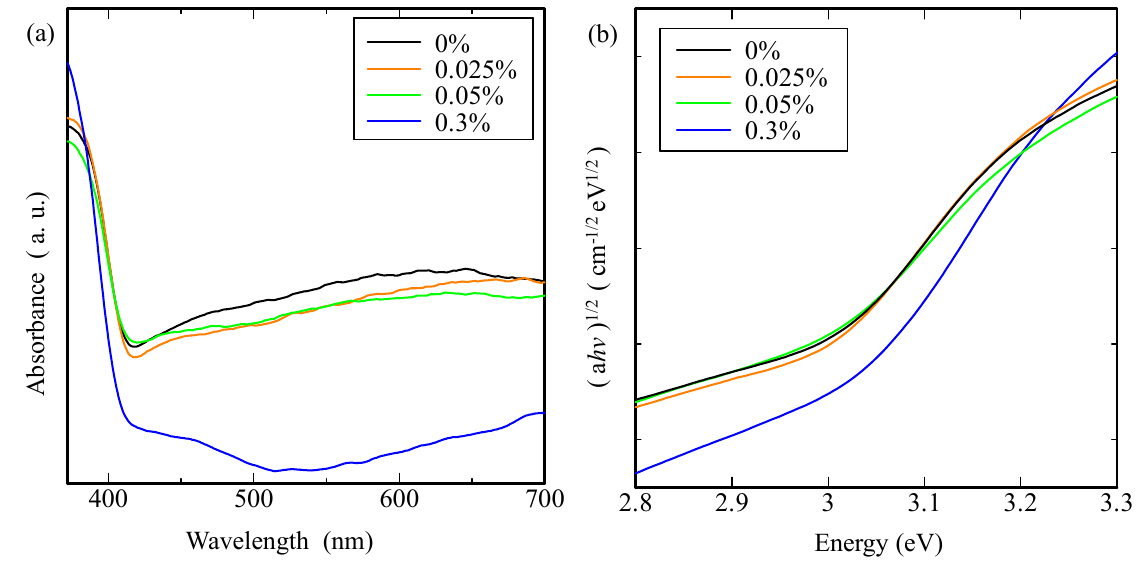
Figure 8. ( a ) UV-Vis absorption spectra; and ( b ) the plots of the transformed Kubelka-Munk function versus the energy of light over the M10- x Cr-973 K/10 h